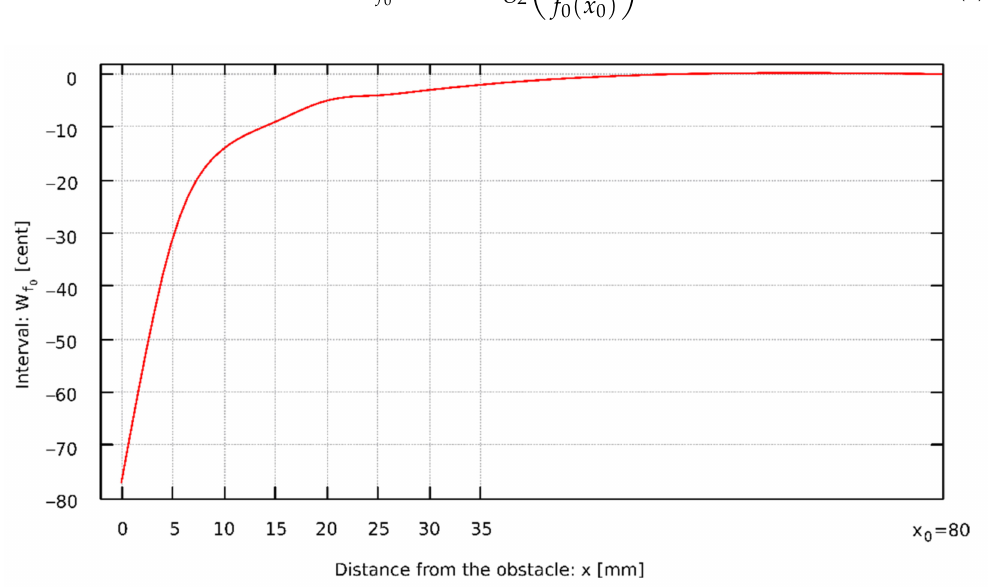
Figure 2. The interval of the fundamental frequency changes in relation to the distance between the obstacle and the pipe lip of Flute 4-foot D